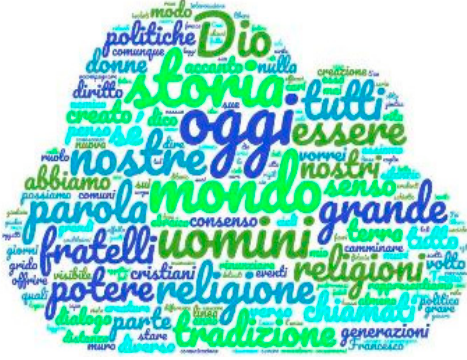
Figure 1. Word Cloud. The data found the word “gospel” with 0.21%, after the 100 words not inside at the cloud, is present in the text count 136 times, and the word “procession”, with 0.28% count, 153 times.